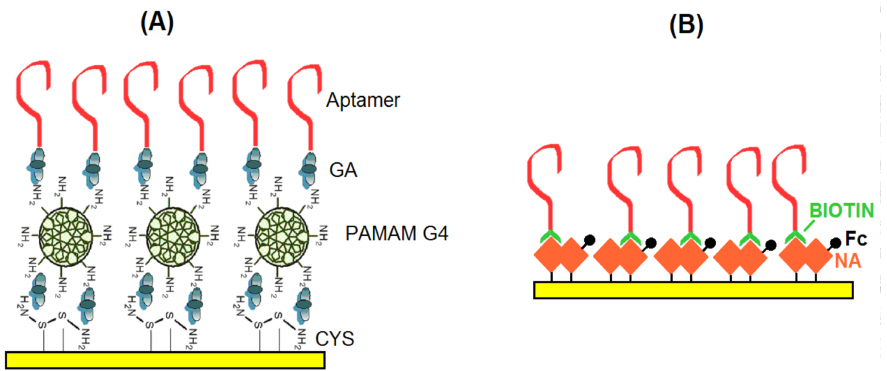
Figure 1. The schemes of aptasensors: ( A ) aptamers are immobilized at the surface of PAMAM G4 dendrimers. ( B ) biotinylated aptamers are immobilized at the neutravidin (NA) layer modified by ferrocene carboxylic acid (Fc). GA—glutaraldehyde,